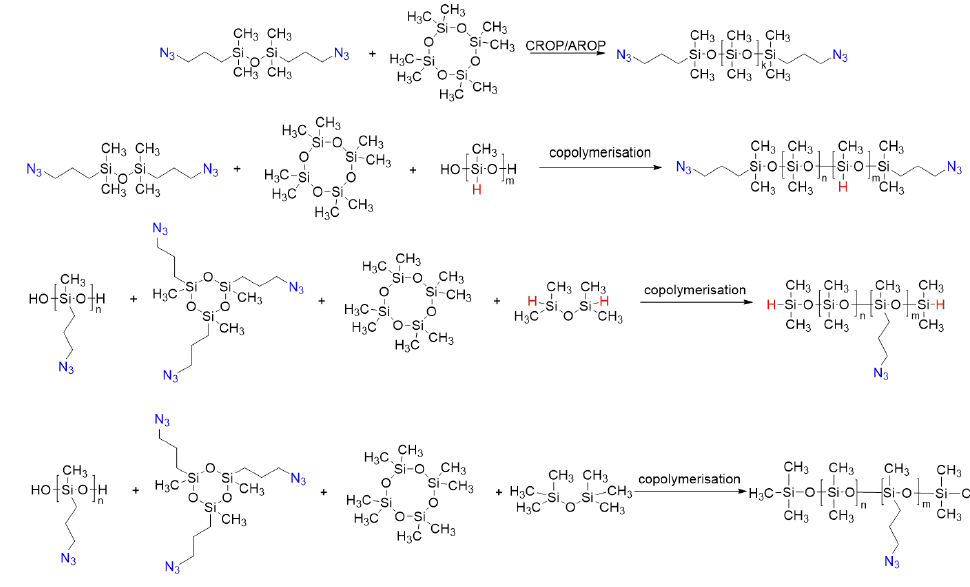
Figure 41. Synthesis of polydimethylsiloxanes (PDMS) with azidopropyl functional groups at the silicon atom by ring-opening polymerization (ROP).